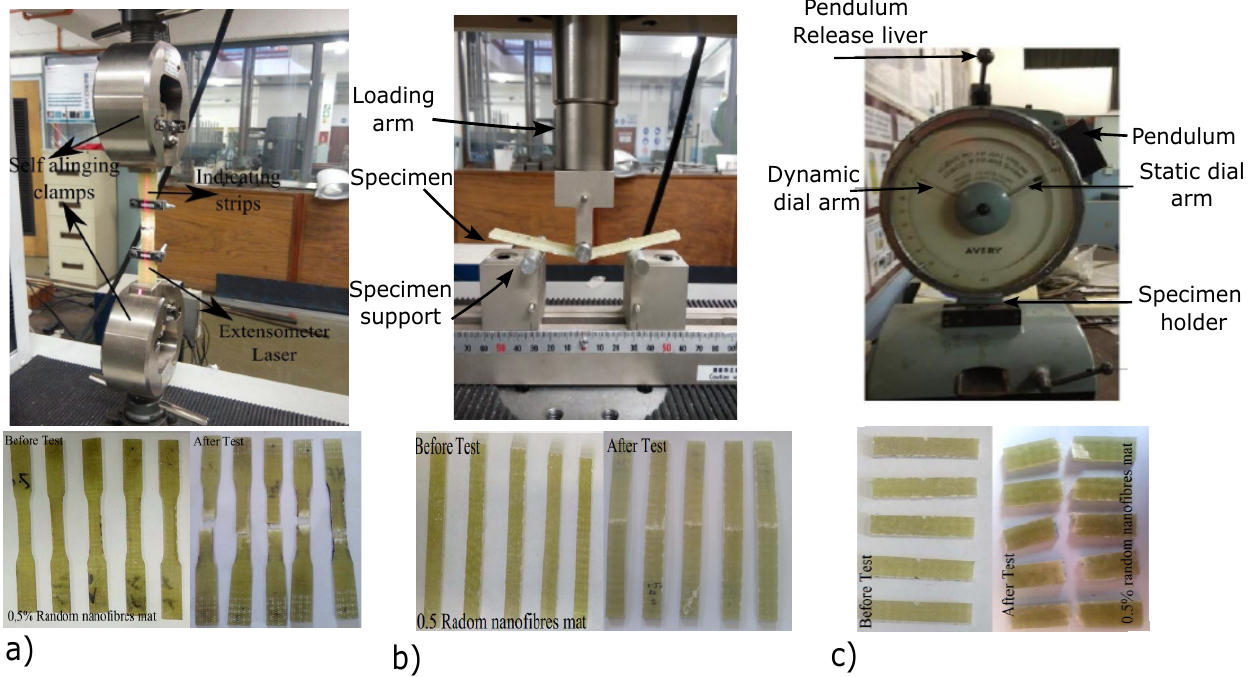
Figure 1. ( a ) Tensile testing setup and specimens. ( b ) Flexural testing setup and specimens. ( c ) Impact testing setup and